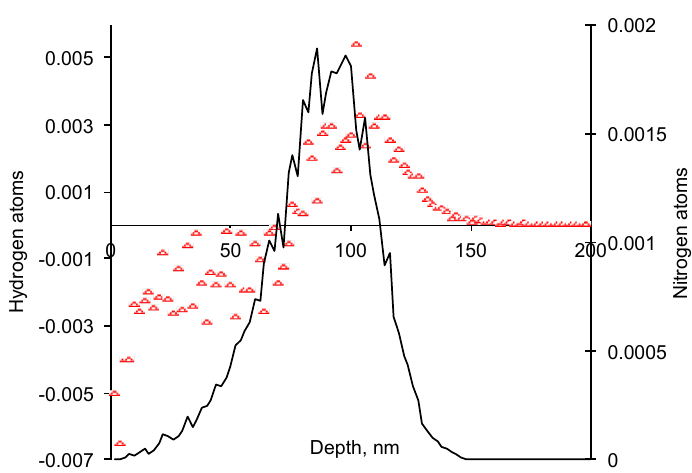
Figure 2. Stopped nitrogen ion profile (black line, units are stopped nitrogen atoms/nm 3 per penetrated nitrogen ion/nm 2 ) and hydrogen atoms balance (units are replaced hydrogen atoms/nm 3 per penetrated nitrogen ion/nm 2 ) with depth of EPDM rubber. By SRIM calculations.